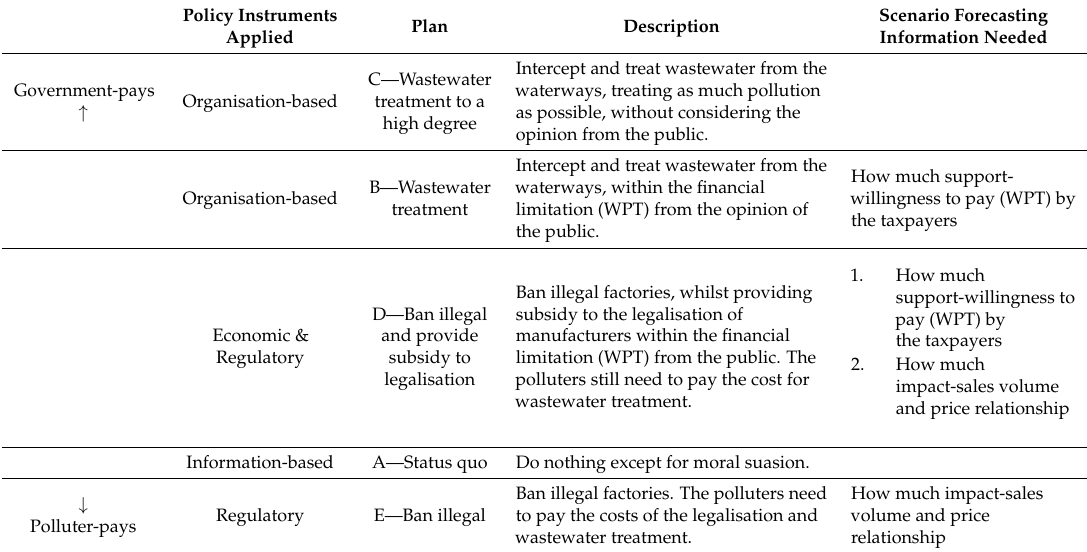
Table 1. The proposal of the rough alternatives for MCDA and the additional information